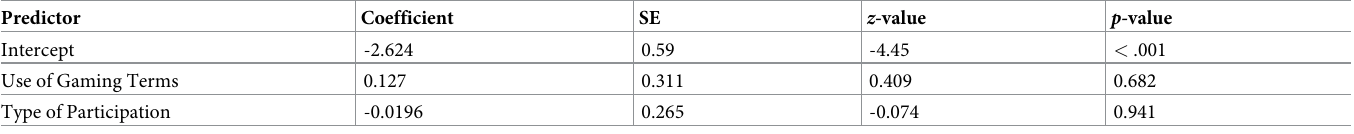
Table 4. Experiment 1: Mixed logit analysis of participant gaming responses predicted by use of gaming terms and type of participation.